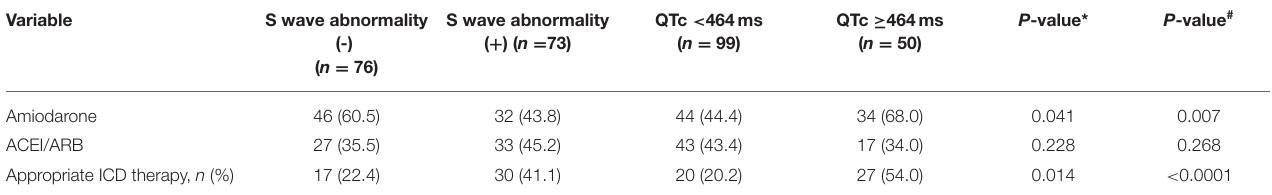
* P represented the comparison between patients with S wave abnormality and without S wave abnormality. # P represented the comparison between Patients with QTc ≥ 464ms and QTc < 464 ms. Values are presented as mean ± SD or median (IQR), or as n (%). HCM, hypertrophic cardiomyopathy; ICD, implantable cardioverter-defibrillator; BMI, body mass index; SBP, systolic blood pressure; DBP, dilated blood pressure; AF, atrial fibrillation;